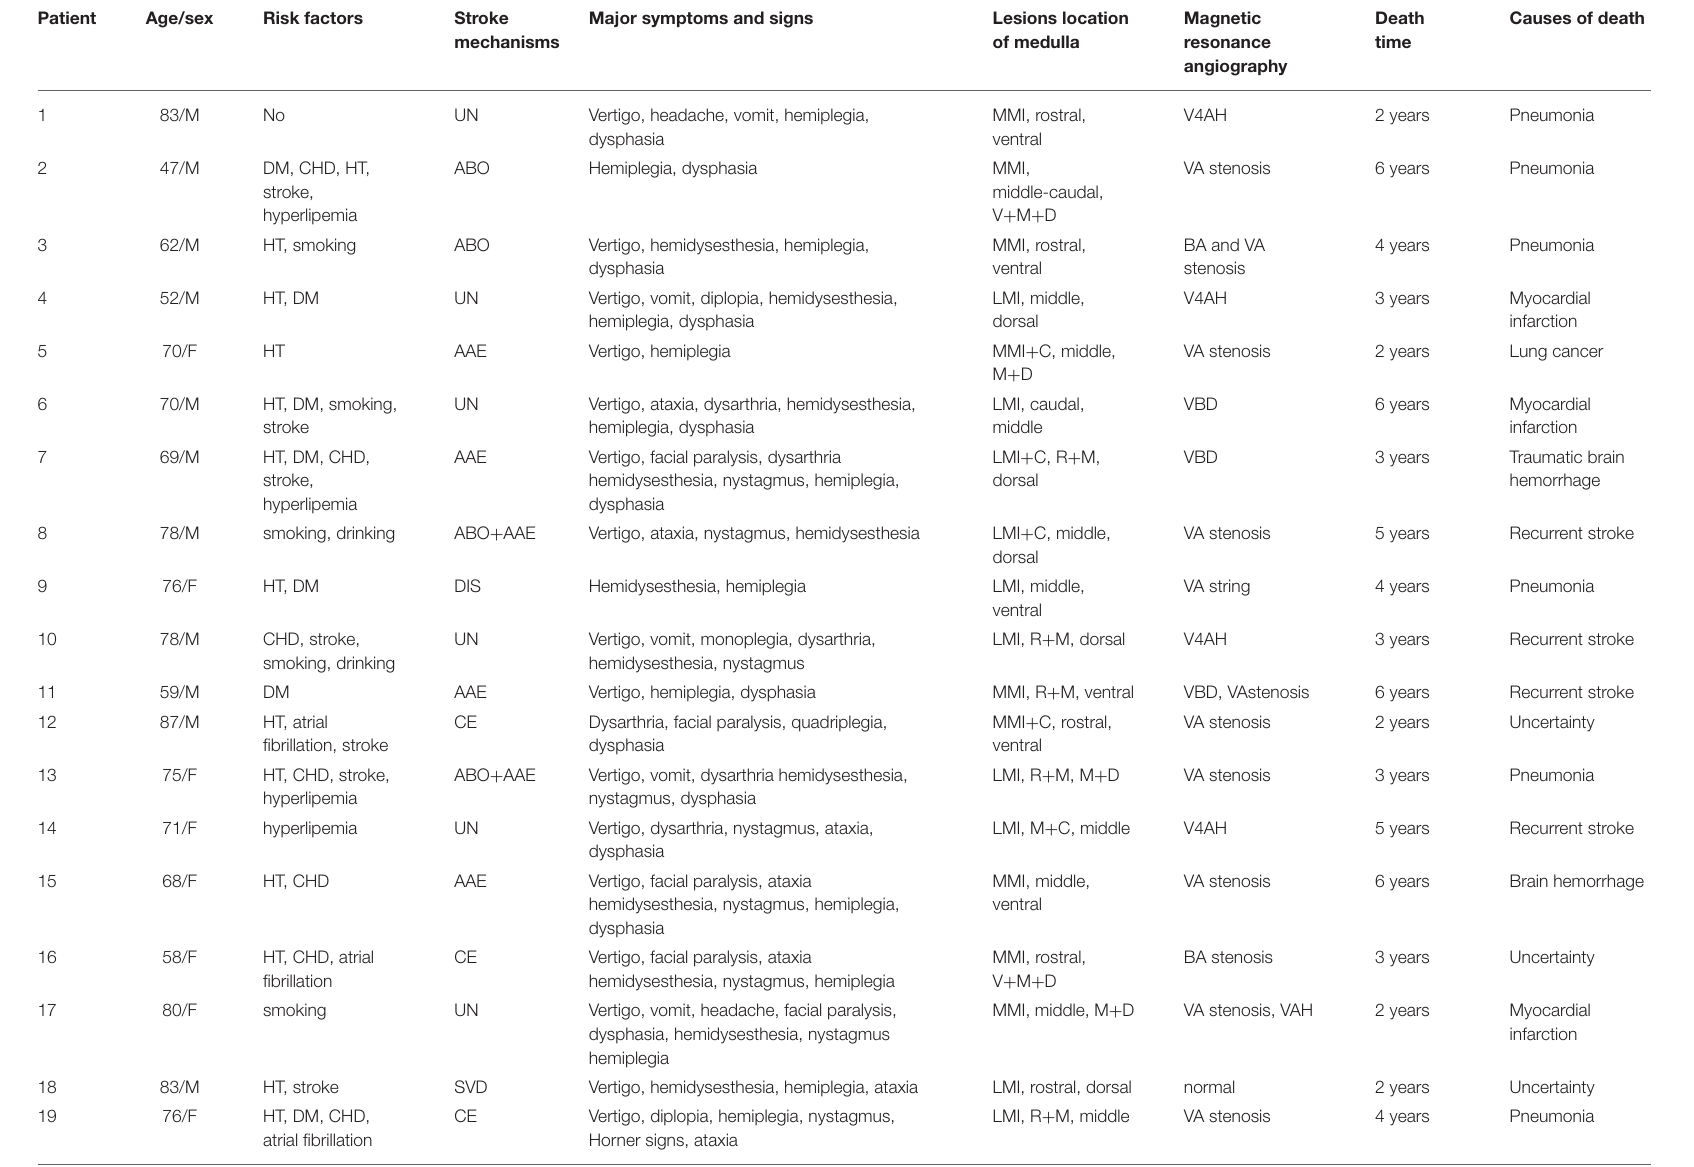
TABLE 3 | Characteristics of 19 dead patients with medullary